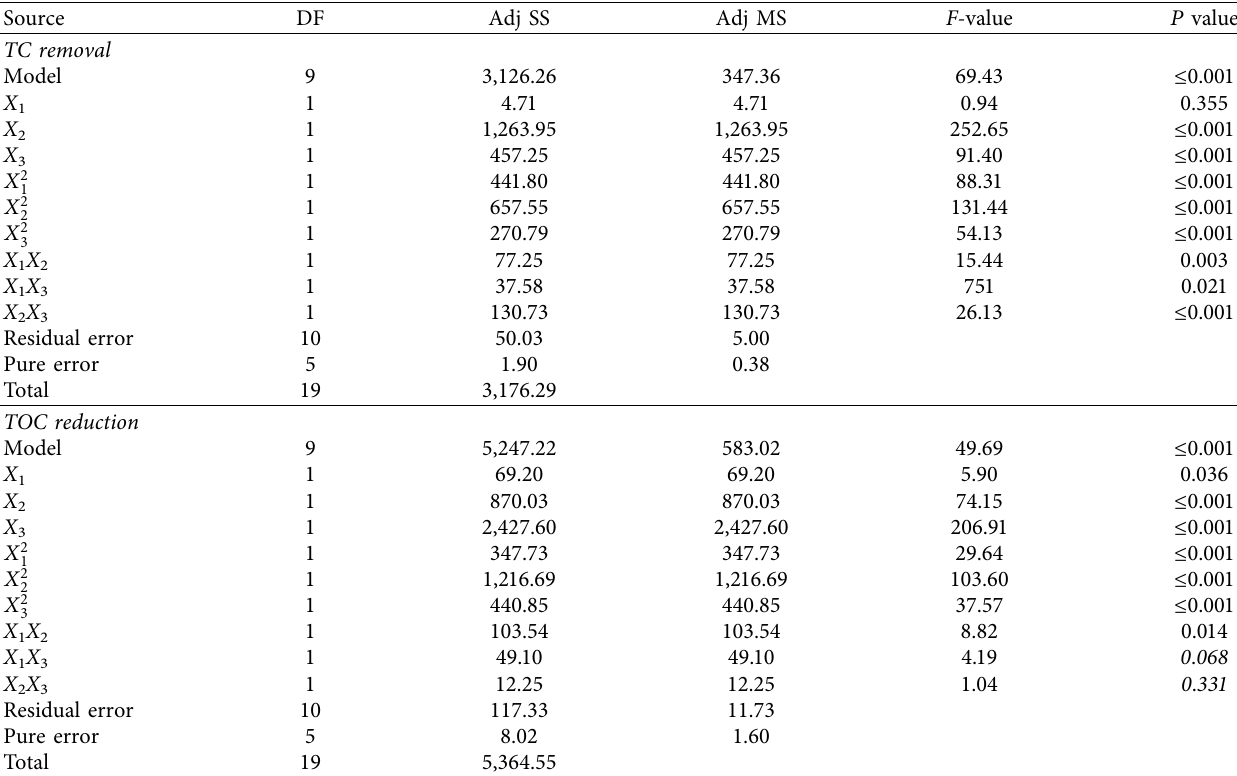
Table 3: ANOVA results for the TC and TOC removal from RPW using EF